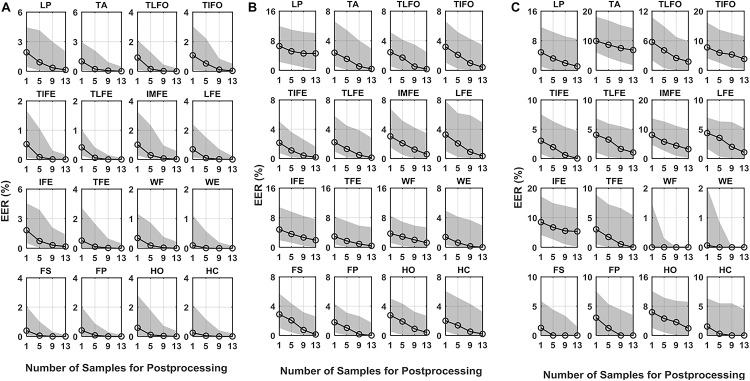
EER of DET for the 16 gestures, LP, TA, TLFO, TIFO, TIFE, TLFE, IMFE, LFE, IFE, TFE, WF, WE, FS, FP, HO, and HC, in three scenarios: (A) normal test, (B) leaked test, and (C) self-test. The dot in each plot represents the median value of EER, and the shaded area represents the range between the first quantile to the third quantile. The scales are different in each plot.